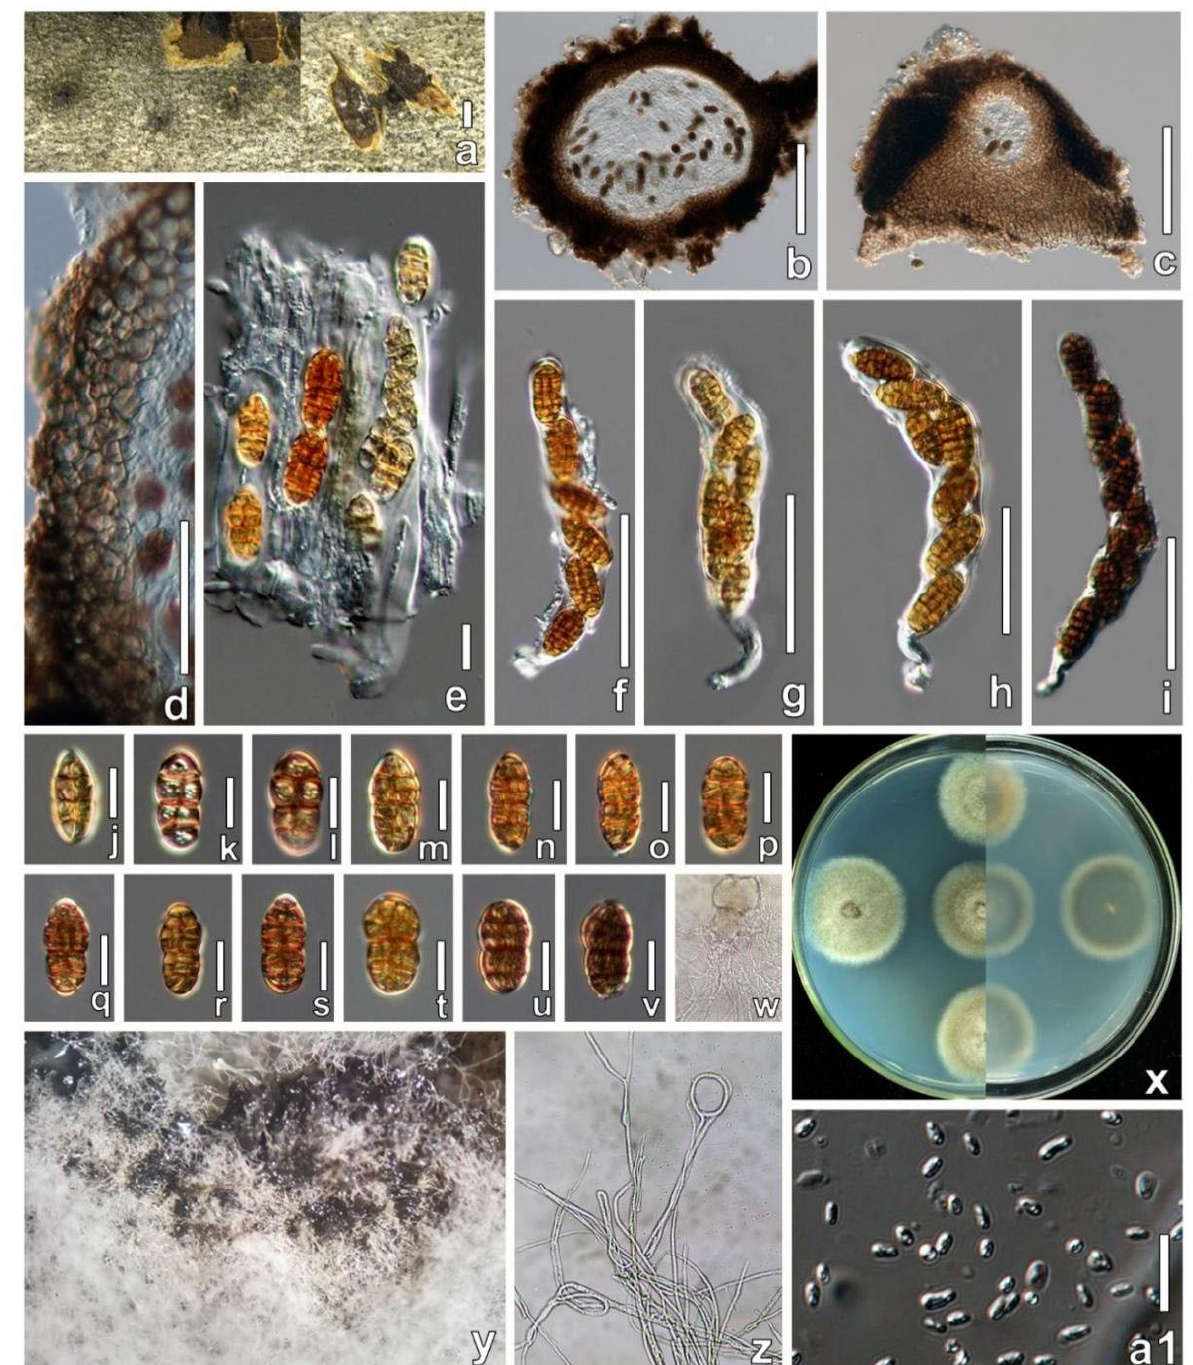
Figure 5. Parafenestella changchunensis (HMJAU 60182, holotype). ( a ) Ascomata on host surface. ( b ) Vertical section through partial ascoma. ( c ) Ostioles. ( d ) Partial peridium. ( e ) Pseudoparaphyses. ( f –